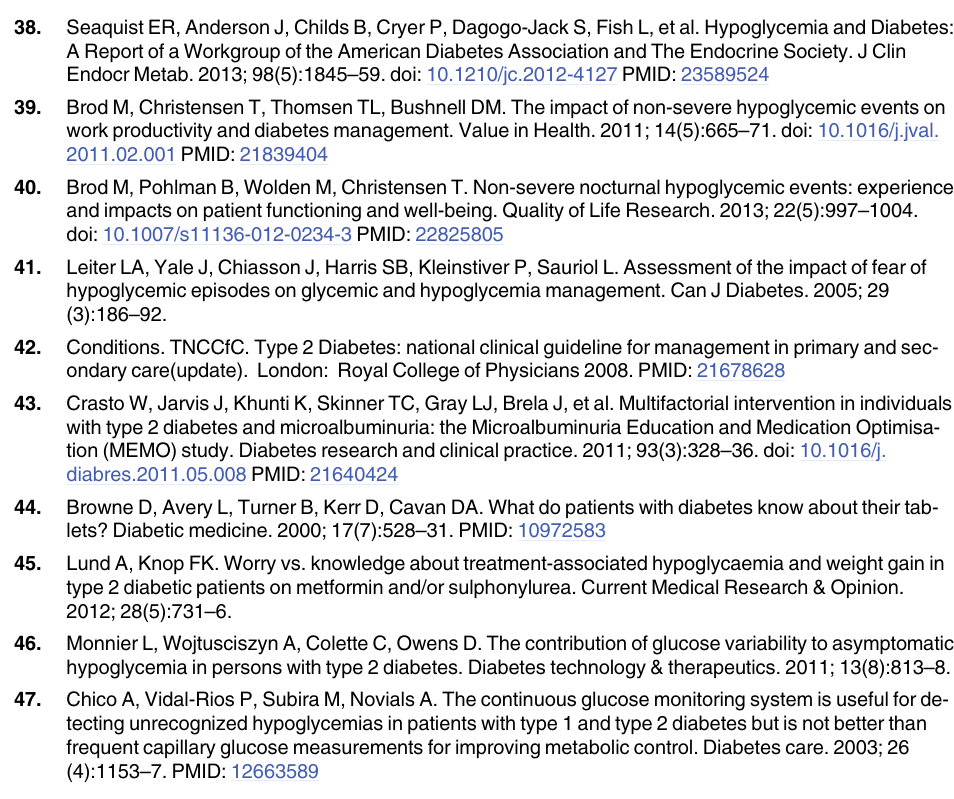
PLOS ONE | DOI:10.1371/journal.pone.0126427 June 10,